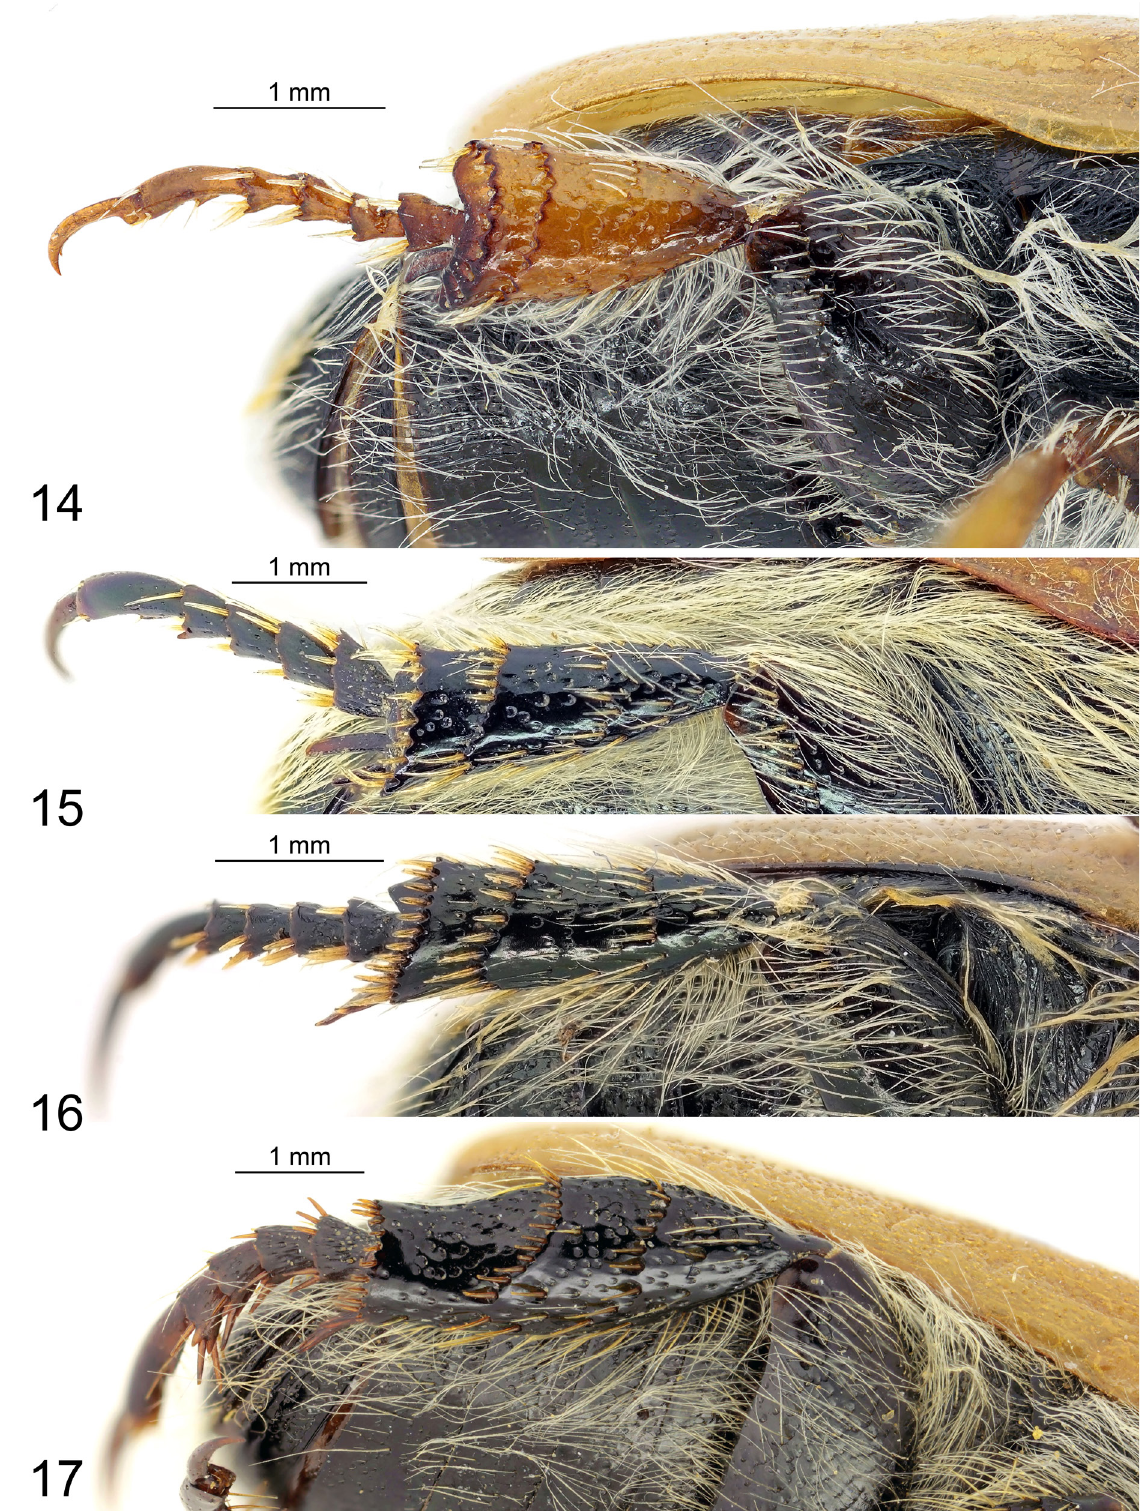
Figs 14–17. Comparative presentation of the posterior tibia in latero-ventral view. 14. Araboplia lorisi gen. et sp. nov. 15 . Dicranoplia deserticola (P.H. Lucas, 1859) . 16. Tribopertha aegyptiaca (C.É. Blanchard, 1851). 17 . Pharaonus fasciculatus (Burmeister,